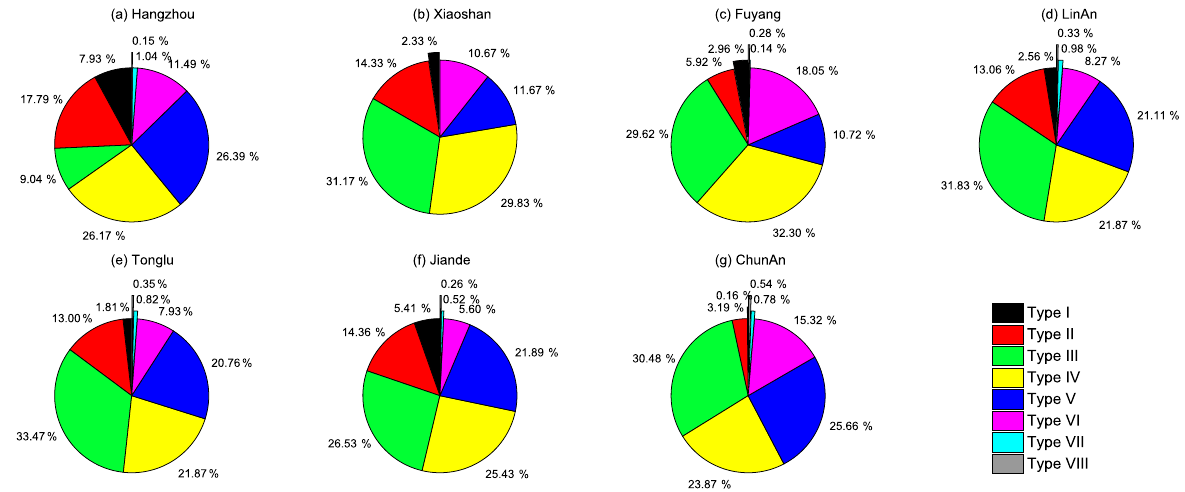
Figure 9. The distribution of the aerosol type classification over (a) Hangzhou, (b) Xiaoshan, (c) Fuyang, (d) LinAn, (e) Tonglu, (f) Jiande and (g) ChunAn. See text for description of types